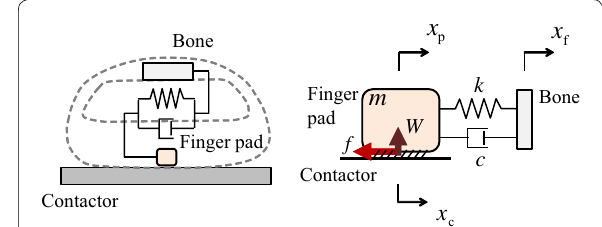
Fig. 5 Physical model of friction between fingertip and contactor. These two models are